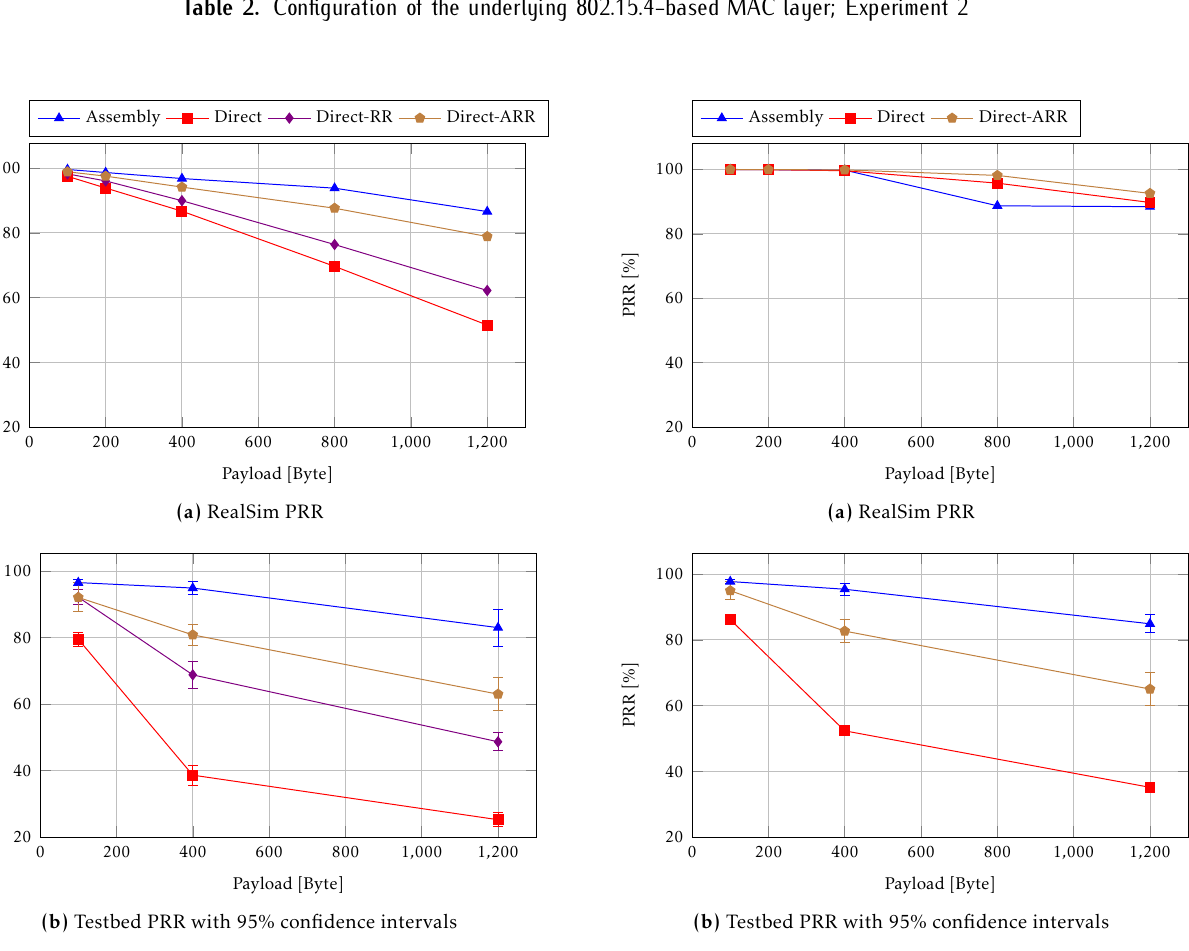
Figure 9. Comparing the packet reception rates of the RealSim and the Testbed Network with a byterate of 37 . 5 B/s ; first set of experiments